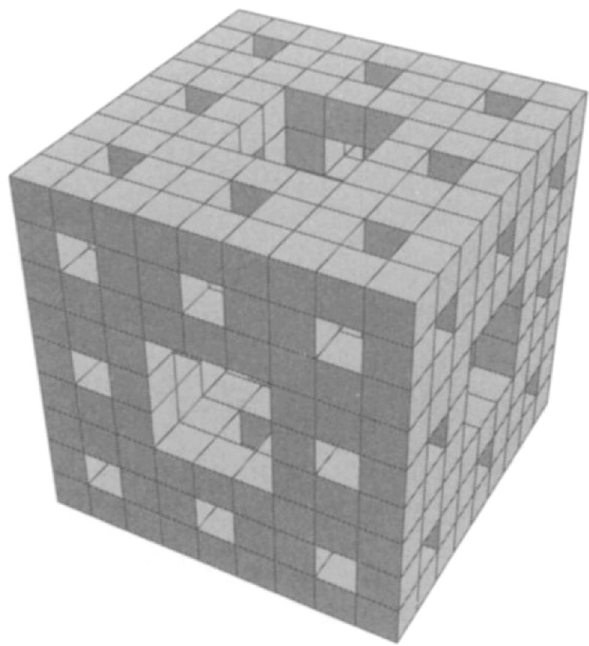
Fig. 3 Construction of a Menger sponge. Adapted with permission from Taylor & Francis, Ltd., ref. 45